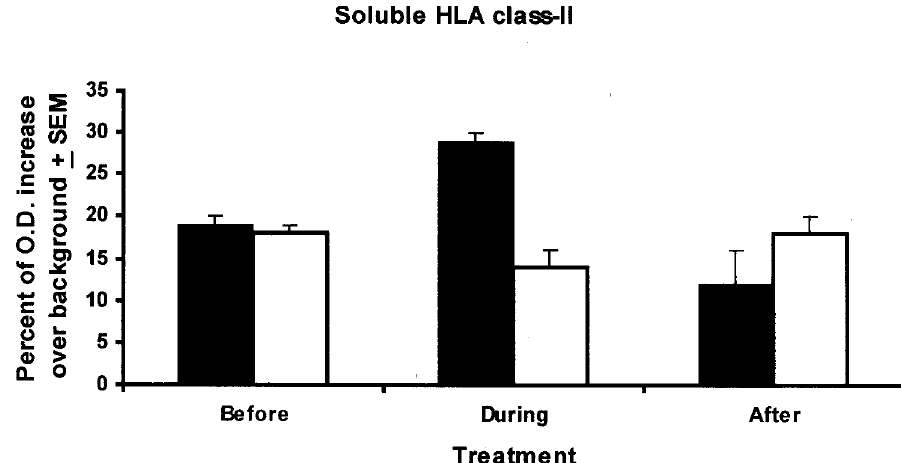
FIG. 3. Serum-soluble human leukocyte antigen (sHLA) class-II levels in women with endometriosis before, during and after treatment with danazol (black bars) or leuprorelin acetate depot (white bars), respectively. For the antibody employed for class II, see Figure 1. The increase obtained in response to danazol during the actual treatment time is of the order of P < 0.001. The results are expressed as the percent of optical density (OD) increase over background levels (±SEM). Background levels (OD values of coating buffer) for the class-II antibody corresponded to 0.075 ± 0.008. The experiment was repeated three times and similar results were